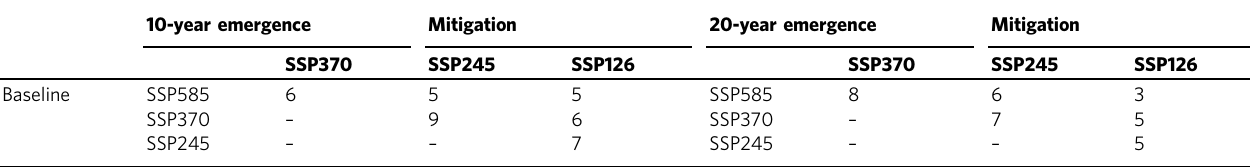
All values are in years and represent the change in the year of emergence derived from comparing a lower emission signal ( “ Mitigation ” ) to a higher emission situation ( “ Baseline ” ). See also Fig. 3 and